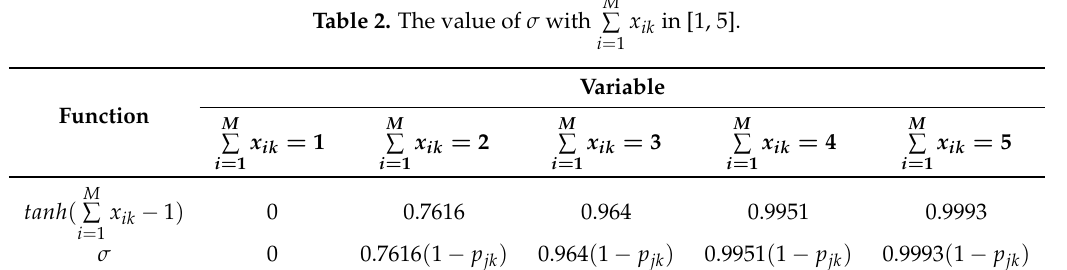
Table 2. The value of σ with